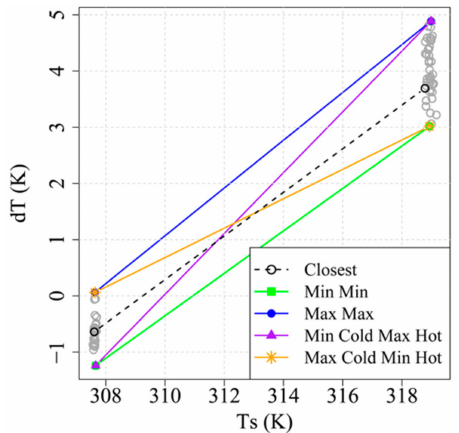
Figure 3. dT vs. T s relationship for each candidate hot and cold pixel. Five selected sets are drawn as lines to encompass every possible combination for calibration of the model. (The locations of these points are shown in Figure